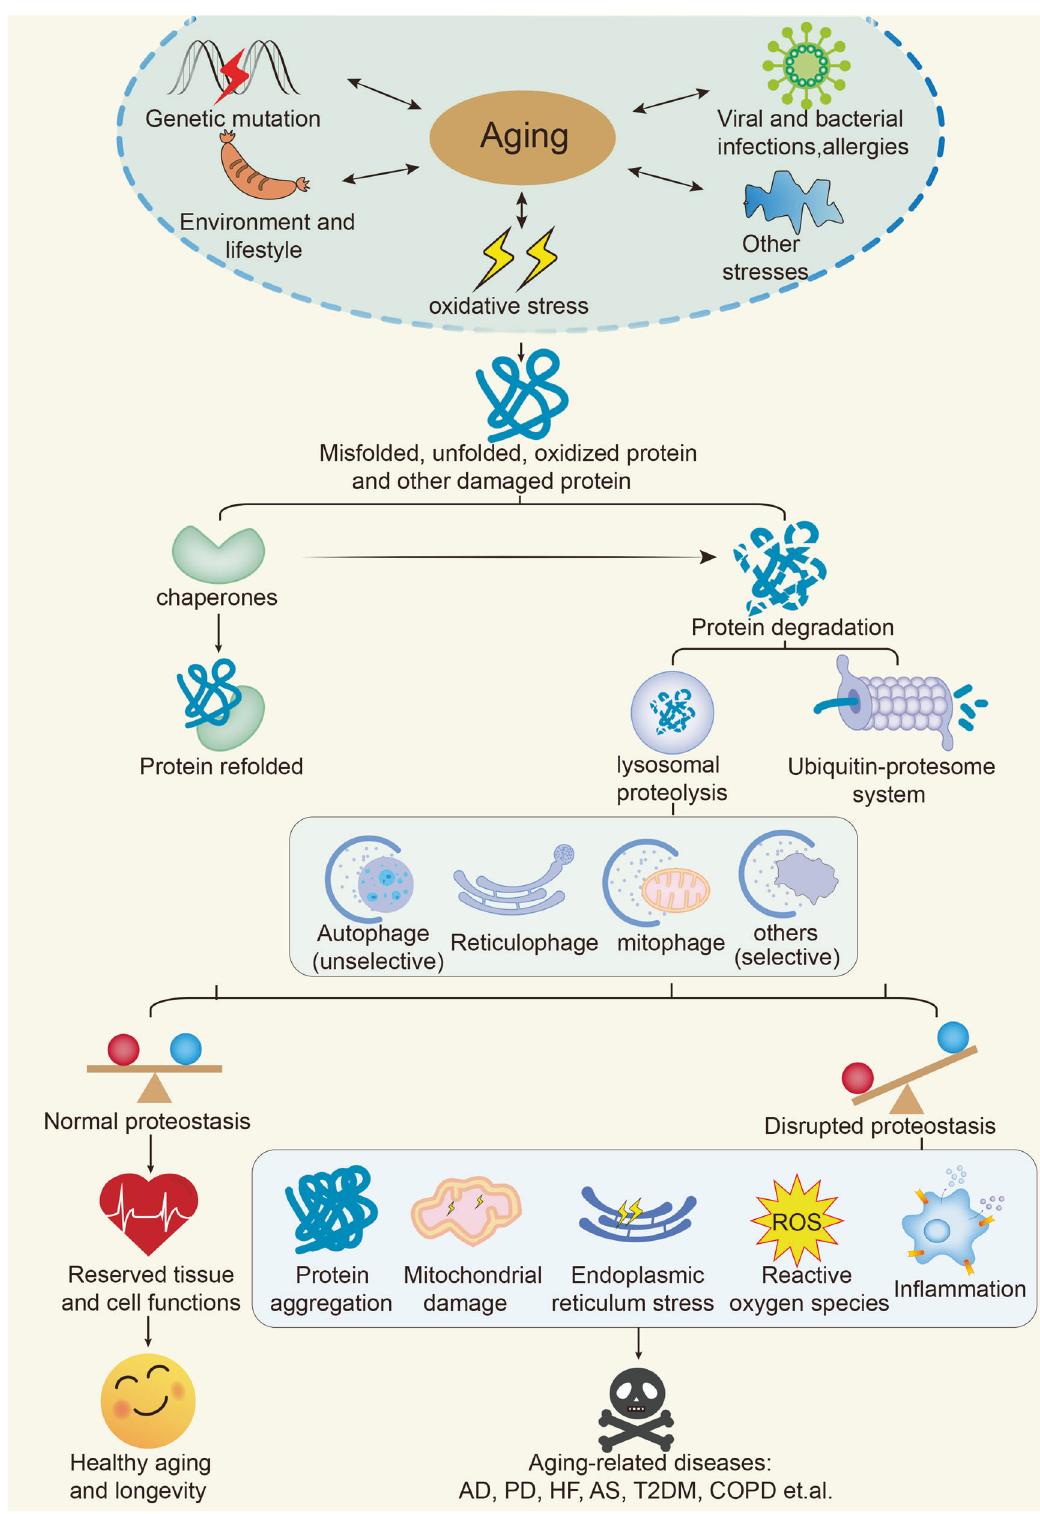
Fig. 7 Molecular mechanisms for proteostasis in aging-related diseases. Aging, genetic mutations, environmental and lifestyle insults, and various other stresses cause increases in the amounts of unfolded, misfolded, and oxidized proteins, which lead to activation of the protein degradation system of the UPS and lysosomal proteolysis (including nonselective autophagy and selective autophagy, such as mitophagy and reticulophagy). Chaperones help refold unfolded proteins and assist in the formation of autophagosomes and ubiquitin-proteasomes. Balanced proteostasis leads to healthy aging and longevity. Disrupted proteostasis induces protein aggregation, cellular organelle function loss, increased ROS production and chronic in fl ammation, which lead to the development of many aging-related diseases